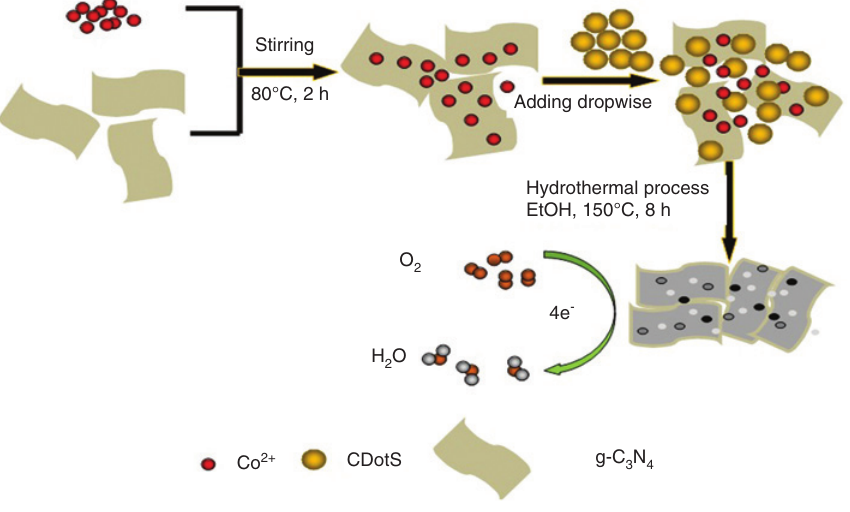
O -C/C N sheets catalysts and their catalytic ability for oxygen reduction 3 4 3 4